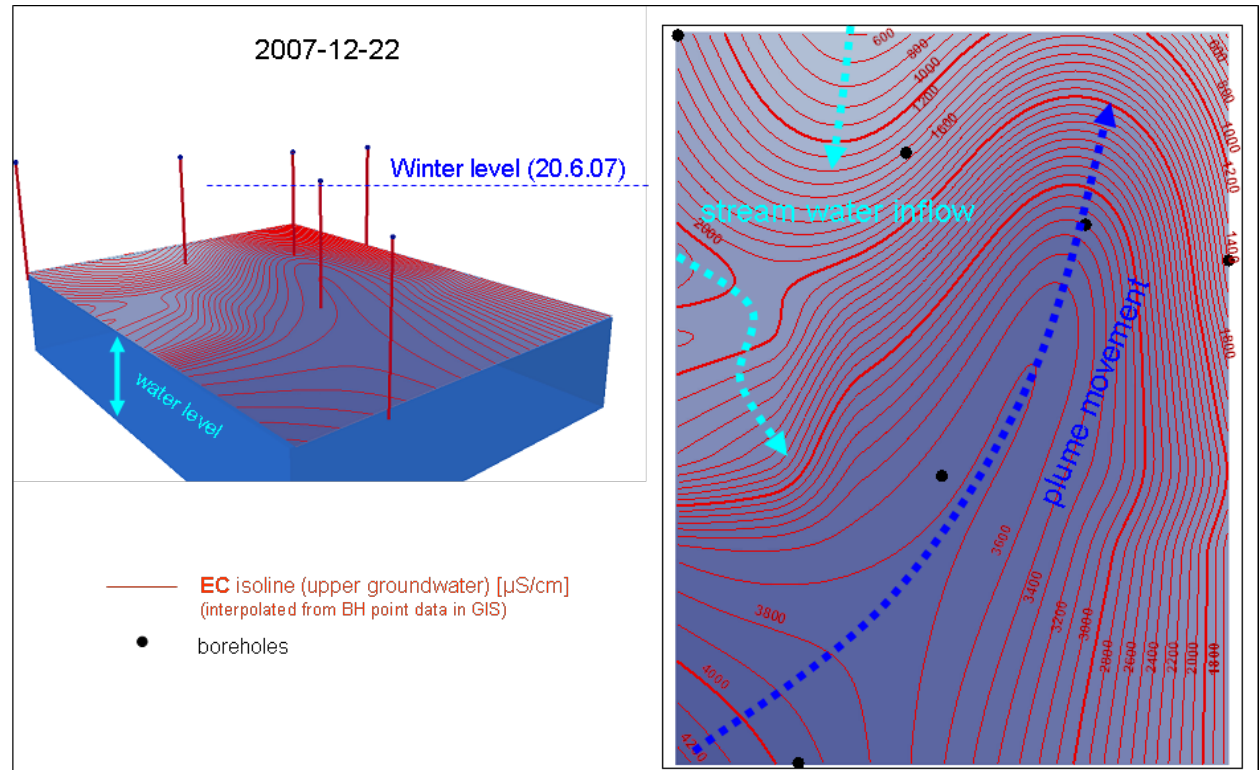
Figure 17. GIS-generated contours of Electrical Conductivity (EC) in shallow alluvial groundwater and water level elevation at the borehole transect at portion 7 and associated interpretations of possible flow patterns indicating plume movement and influx of (cleaner) stream